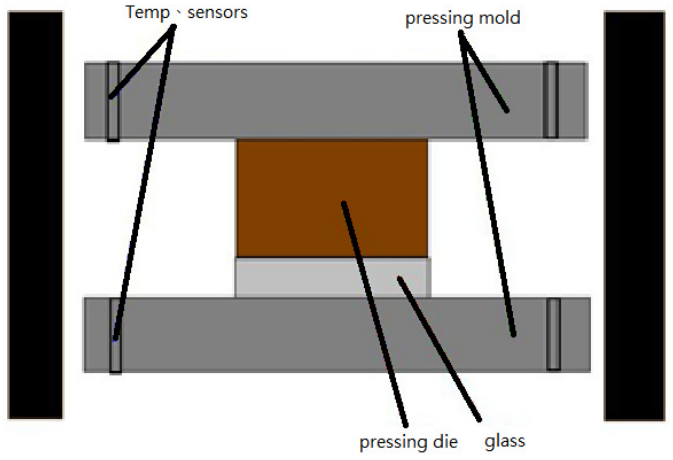
Figure 4. Hot-pressing stage of glass molding.